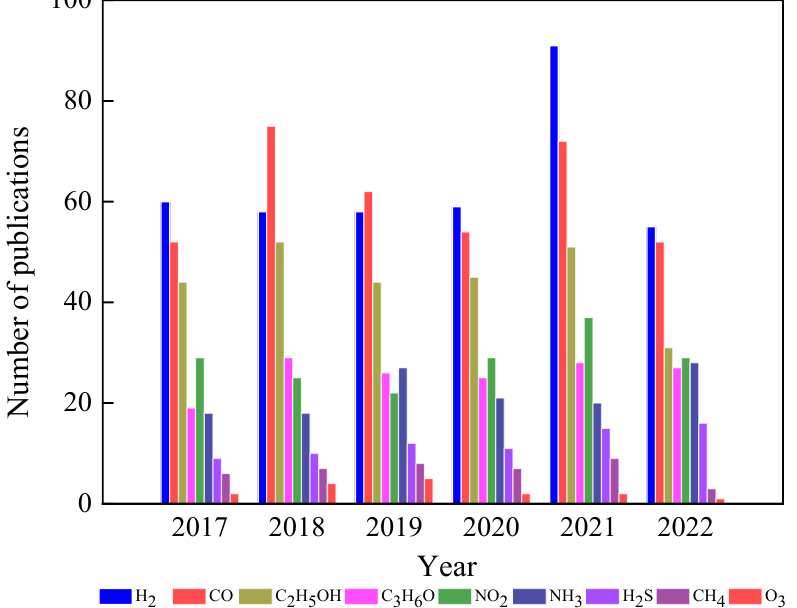
Figure 5. Use of TiO 2 in gas- sensing applications in the last five years. Source : Web of Science.